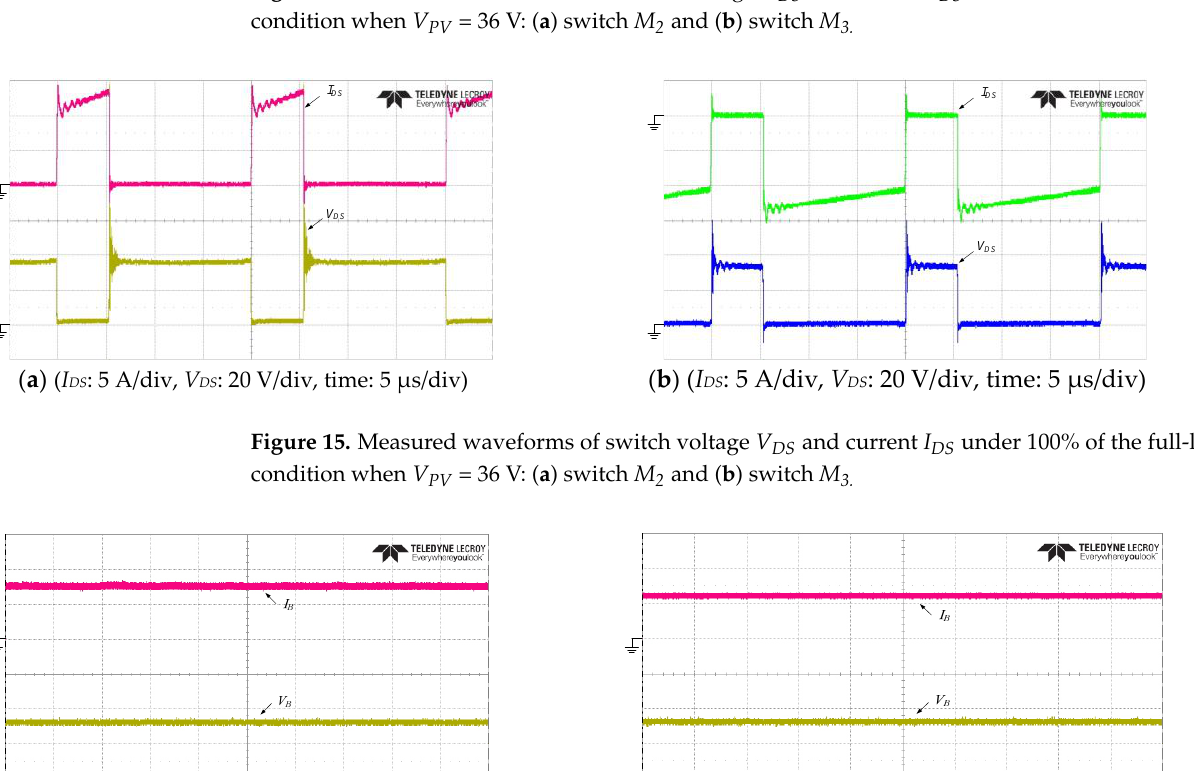
condition when V PV = 36 V: ( a ) switch M 2 and ( b ) switch M 3. Figure 14. Measured waveforms of switch voltage V DS and current I DS under 25% of the full-load